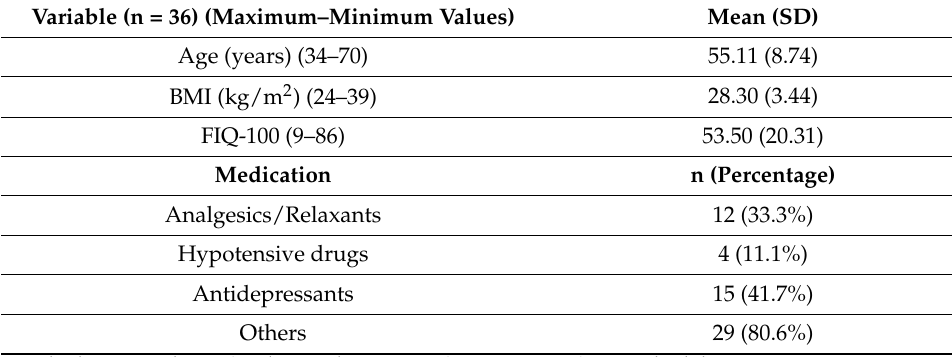
Table 1. Characteristics of the